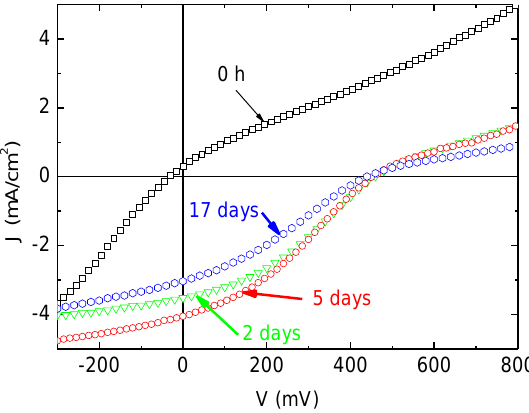
Figure 2. Evolution of the J-V characteristics over the duration of room air exposure of an OPVC with Alq (3 nm)/MoO (6 nm) as the cathode buffer layer (CBL). 3 3